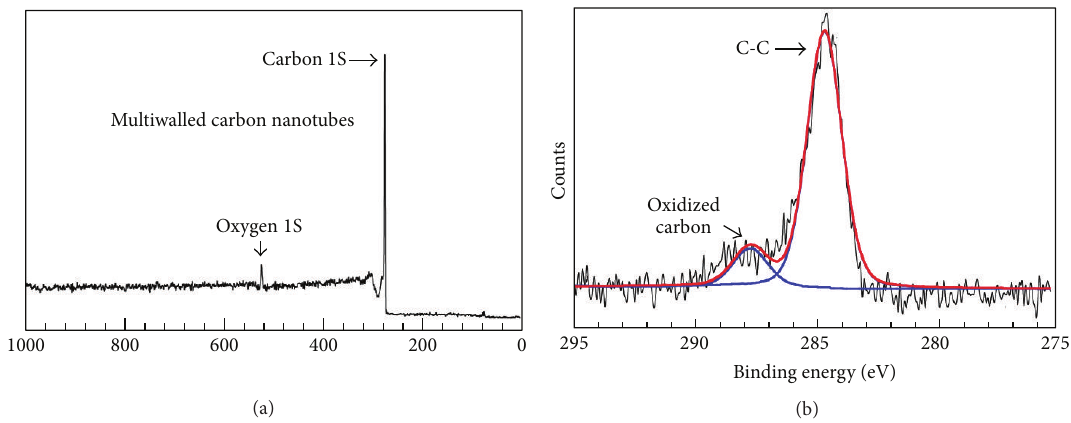
Figure 5: XPS spectra of carbon nanotubes (of C1s) with two different resolutions: (a) low and (b)